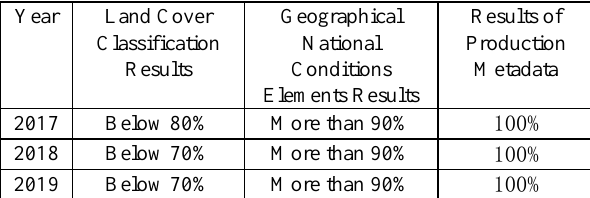
Table 2. Pass rate of quality review